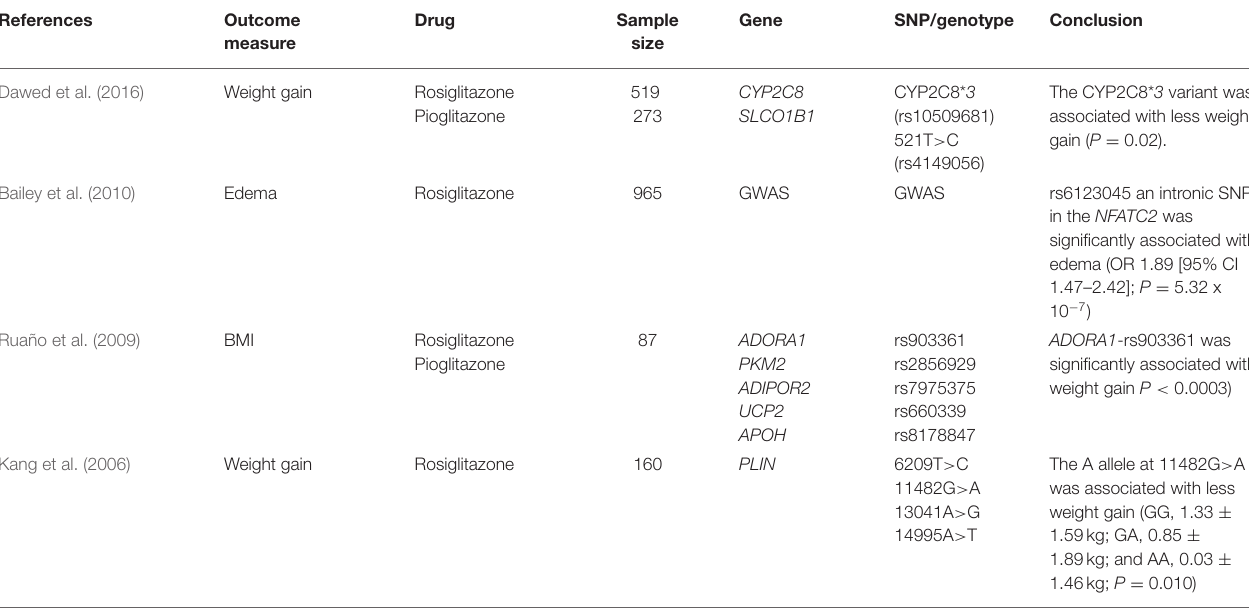
TABLE 5 | Association between thiazolidinediones and selected SNPs for the incidence of weight gain and